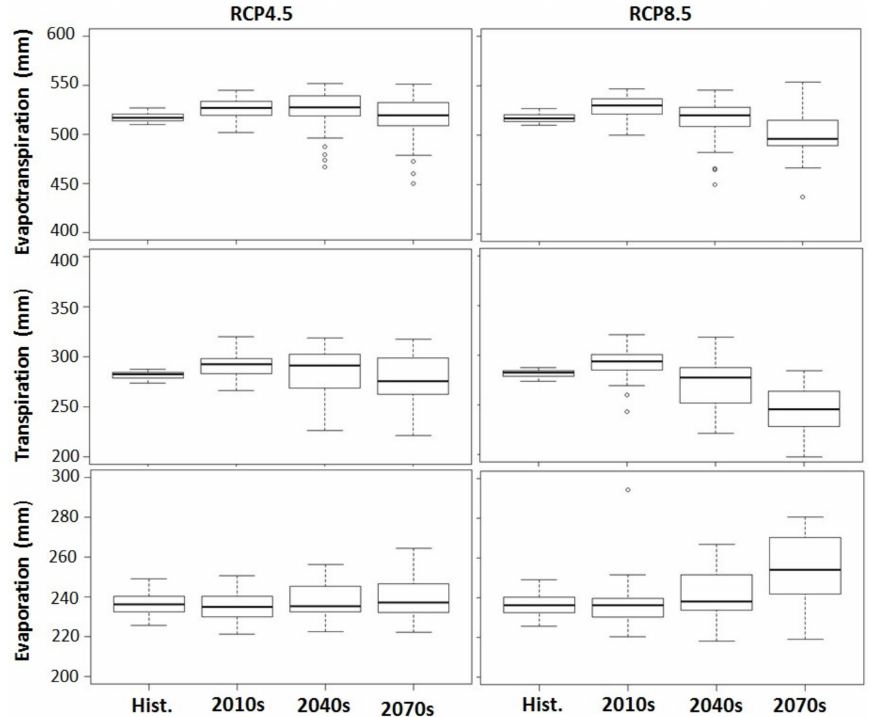
Figure 7. Percentage (%) change of evapotranspiration, transpiration and evaporation during the cropping period (June-September) in Jeonju metrological station area for the 2010s (2nd column), 2040s (3rd column), 2070s (4rd column) considering RCP4.5 ( left side ) and (2) RCP 8.5 ( right side ) scenarios relative to the historical period (1st column) considered as baseline